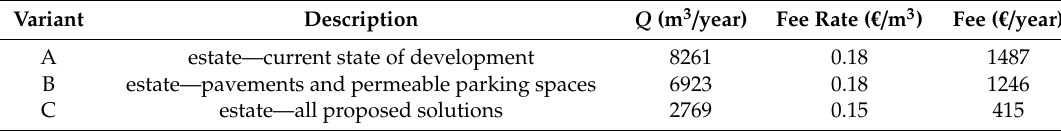
Table 15. Water services fees—fees for rainwater drainage.